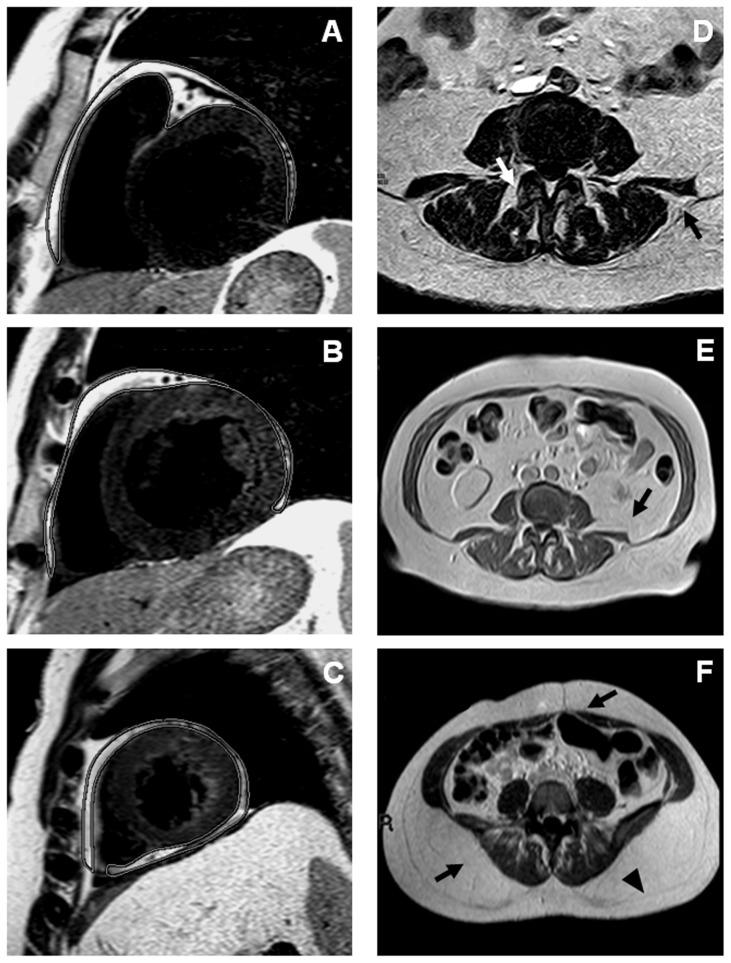
MRI measurements of adipose tissue depots.(A) Volumetric assessment of EAT. The contours of EAT were outlined in end-diastolic images of short-axis views covering the whole left and right ventricle. (B) IMAT of the erector spinae muscles at L3–L4 disk level. IMAT is visible between muscle groups (white arrow) and beneath the muscle fascia (black arrow). Abdominal L3–L4 (C) and L4–L5 (D) MRI scans with representation of IAAT and SAT respectively (black arrows). The black arrow head indicates the fascia trasversalis dividing SAT into a deep and a superficial layer.